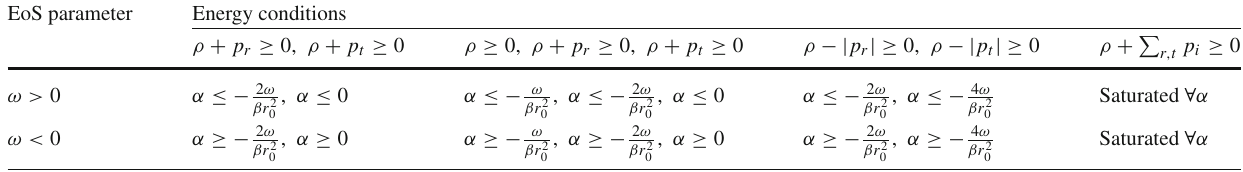
Table 1 The general constraints on α , obtained from the energy conditions for the model #1, by considering both positive and negative EoS parameter ω EoS parameter